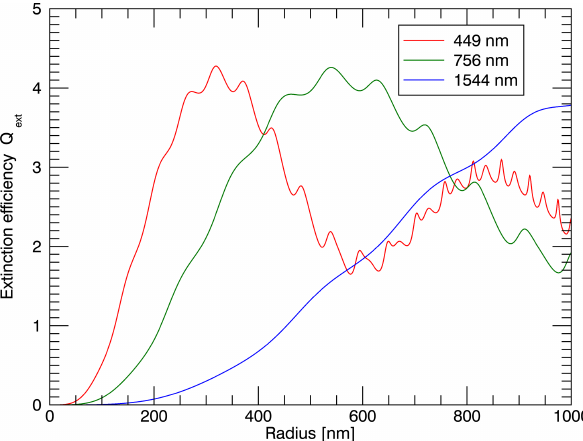
Figure 3. Extinction efficiencies of single (monodisperse) aerosols at radii between 1 and 1000nm from Mie calculations for the three wavelengths used in the retrieval of the current work.